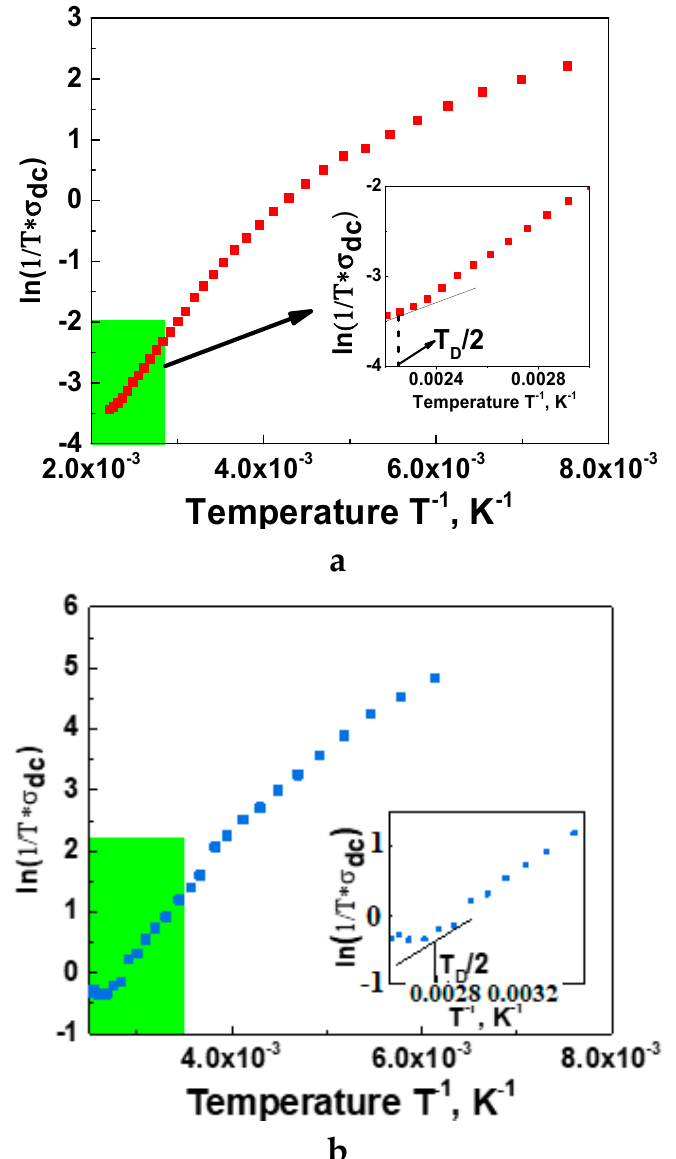
Figure 6. Dependence of ln(1/ σ DCT ) on 1/T. Estimation of Debye temperature for La-CMFCNO ( a ) and Nd-CMFCNO ( b ).